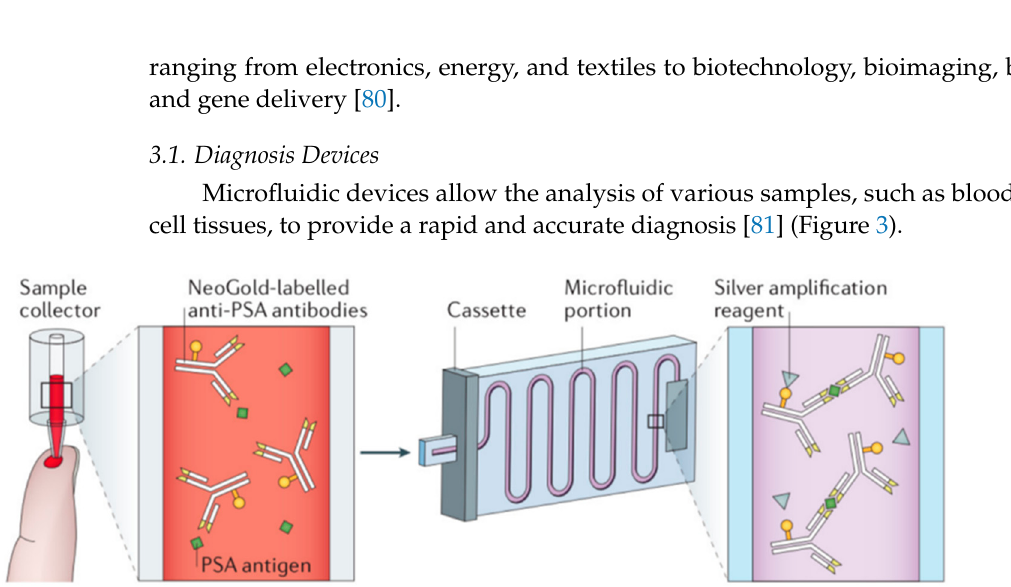
Figure 3. Example of a microfluidic diagnosis device that can detect prostate-specific antigen (PSA) in less than 15 min. Reprinted from an open-access source [82].